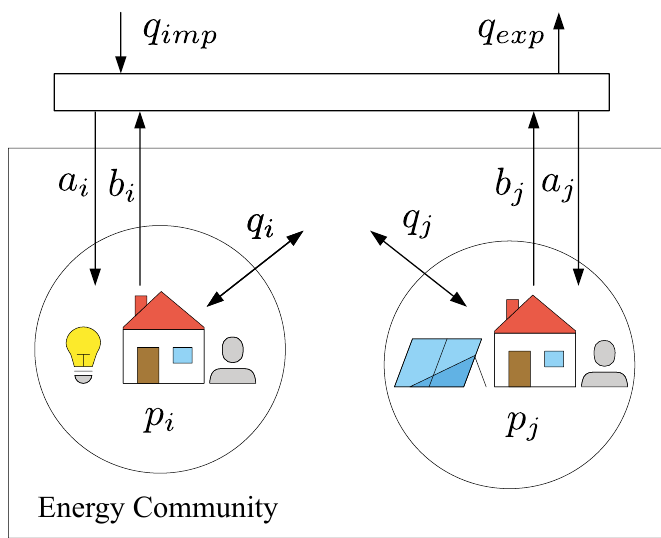
Figure 1. The local energy market of an energy